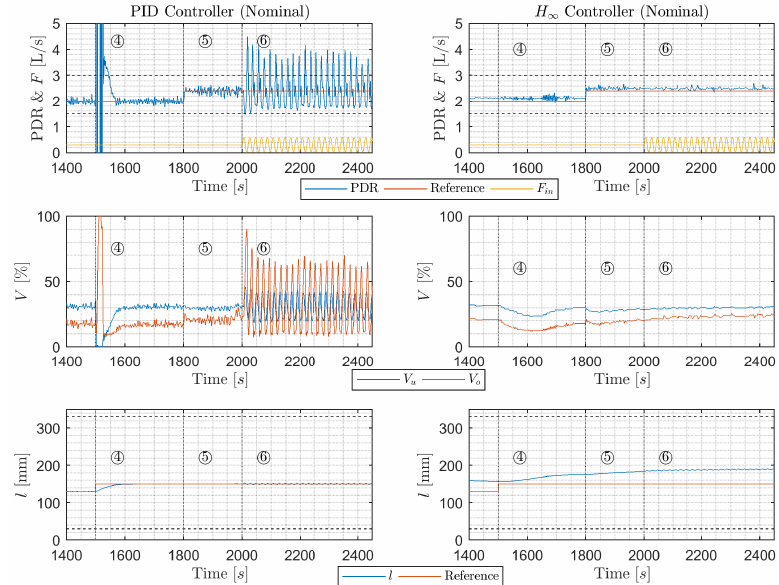
Figure 8. Performance analysis of the H ∞ control solution in comparison to the PID control solution in the pilot plant experiments under Nominal operation; the scenario changes are indicated by dotted lines, while the minimum and maximum limits are represented with dashed horizontal lines.